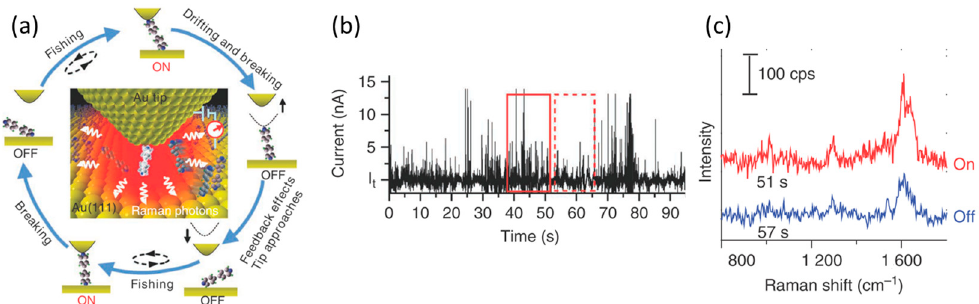
Figure 2. ( a ) Schematic view of the fishing-mode tip-enhanced Raman scattering (FM-TERS) for simultaneous measurement of conductance and TERS for single-molecular junctions; ( b ) Time course of conductance for the Au scanning tunneling microscopy tip/4,4 ′ -bipyridine/Au (111) system; ( c ) TERS spectra corresponding to the ON and OFF states. ( λ ex : 632.8 nm, laser intensity: 5 mW) [33].